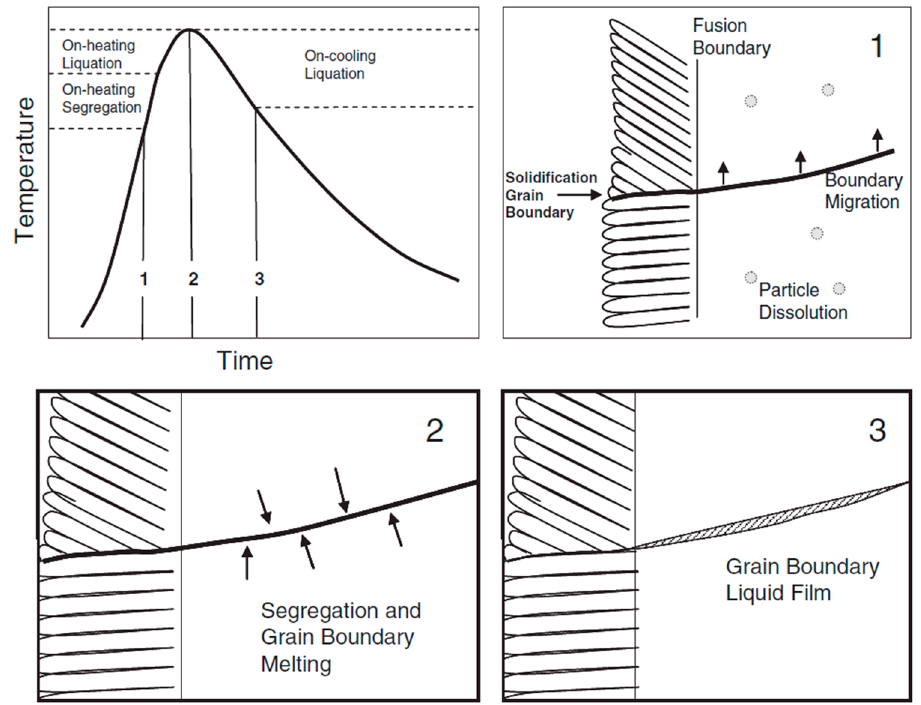
Figure 18. Solute segregation and localized melting along grain boundaries in HAZ during different temperature phases in welding [65]; 1, 2, and 3 define progression phases of liquation